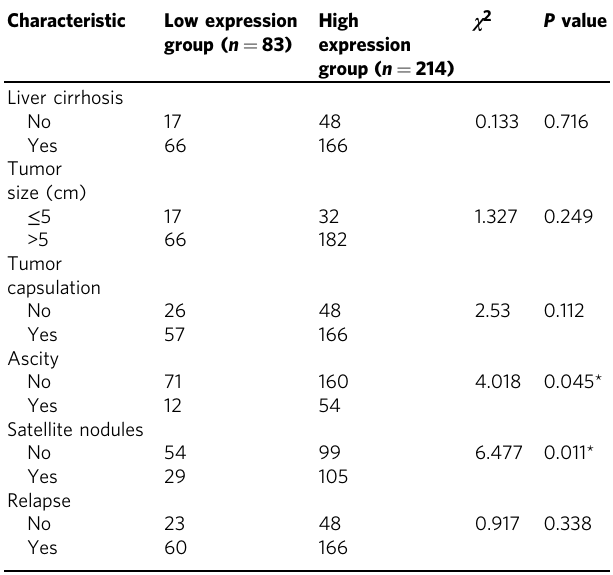
Table 1 Relationship between expression of CHML in HCC and clinicopathologic features